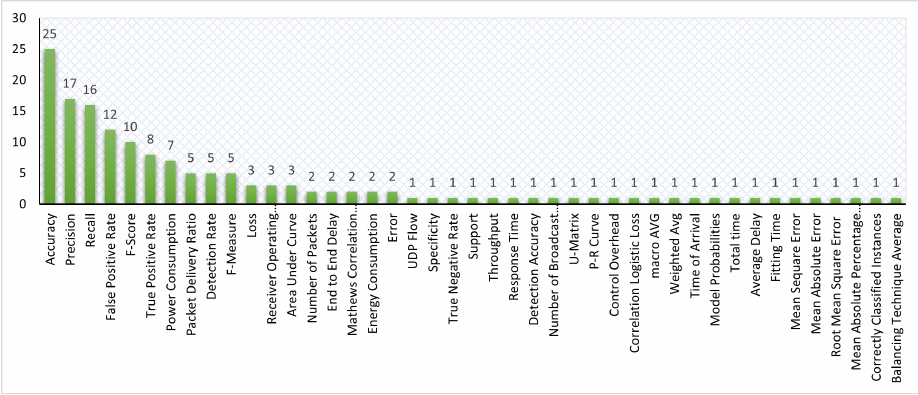
Figure 10. Distribution of the used metrics and parameters in the existing